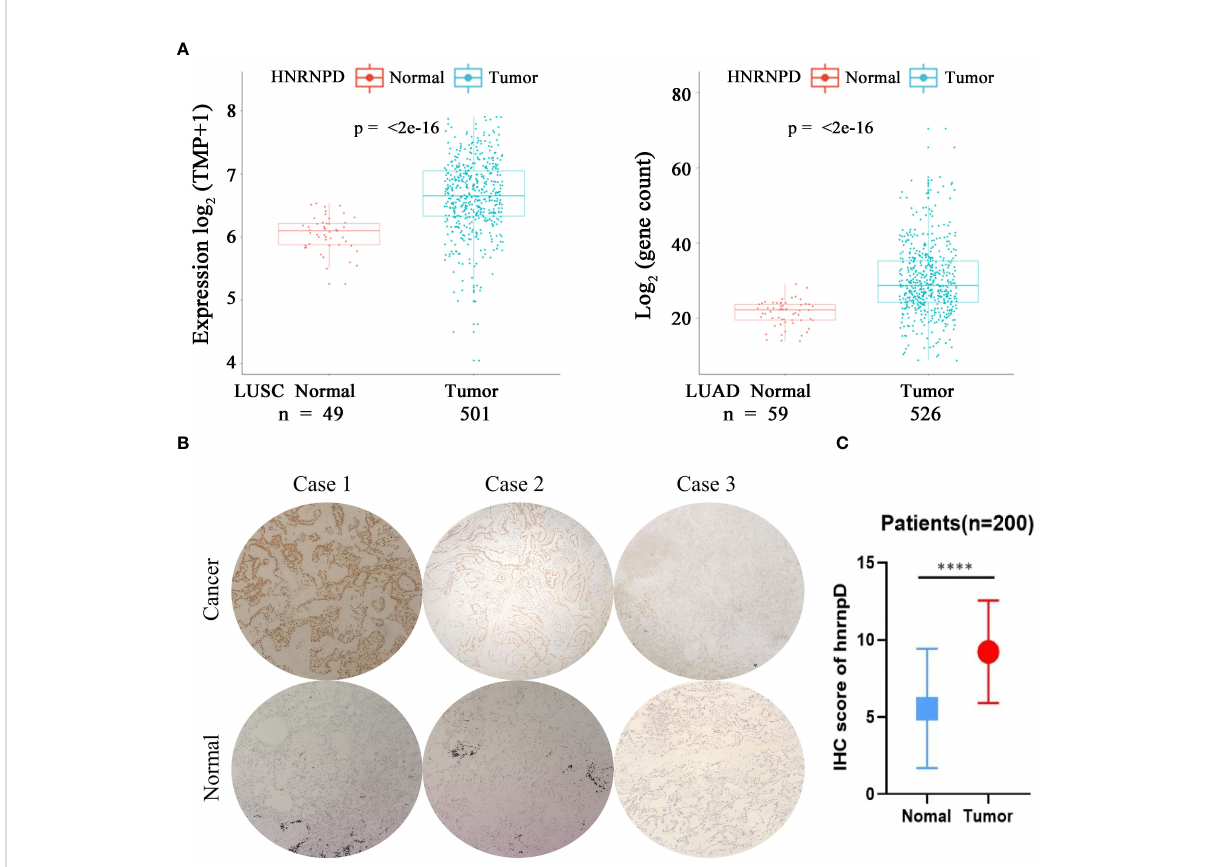
FIGURE 5 The expression of HNRNPD in lung cancer tissues was signi fi cantly higher than that in para-carciooma tussers. (A) The Cancer Genome Atlas database showed that the expression of NR2F6 in lung adenocarcinoma and squamous cell lung carcinoma was signi fi cantly higher than that in the paired para-carcinoma tissues, and the difference was statistically signi fi cant ( P < 0.05). (B) Representative images of immunohistochemical results of HNRNPD in lung cancer tissues. The three images above show lung cancer tissues, representing positive, weak positive, and negative staining. The three images below show the corresponding staining results of para-carcinoma tissues. (C) The immunohistochemical results showed that HNRNPD protein expression in lung cancer tissues was signi fi cantly higher than that in para-carcinoma tissues, and the difference was statistically signi fi cant. ***** P <